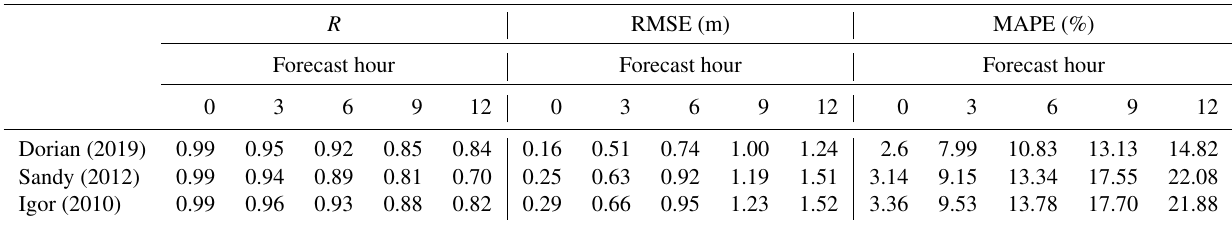
Table 3. LSTM forecast performance for Hurricanes Dorian, Sandy, and Igor. R Forecast hour Forecast